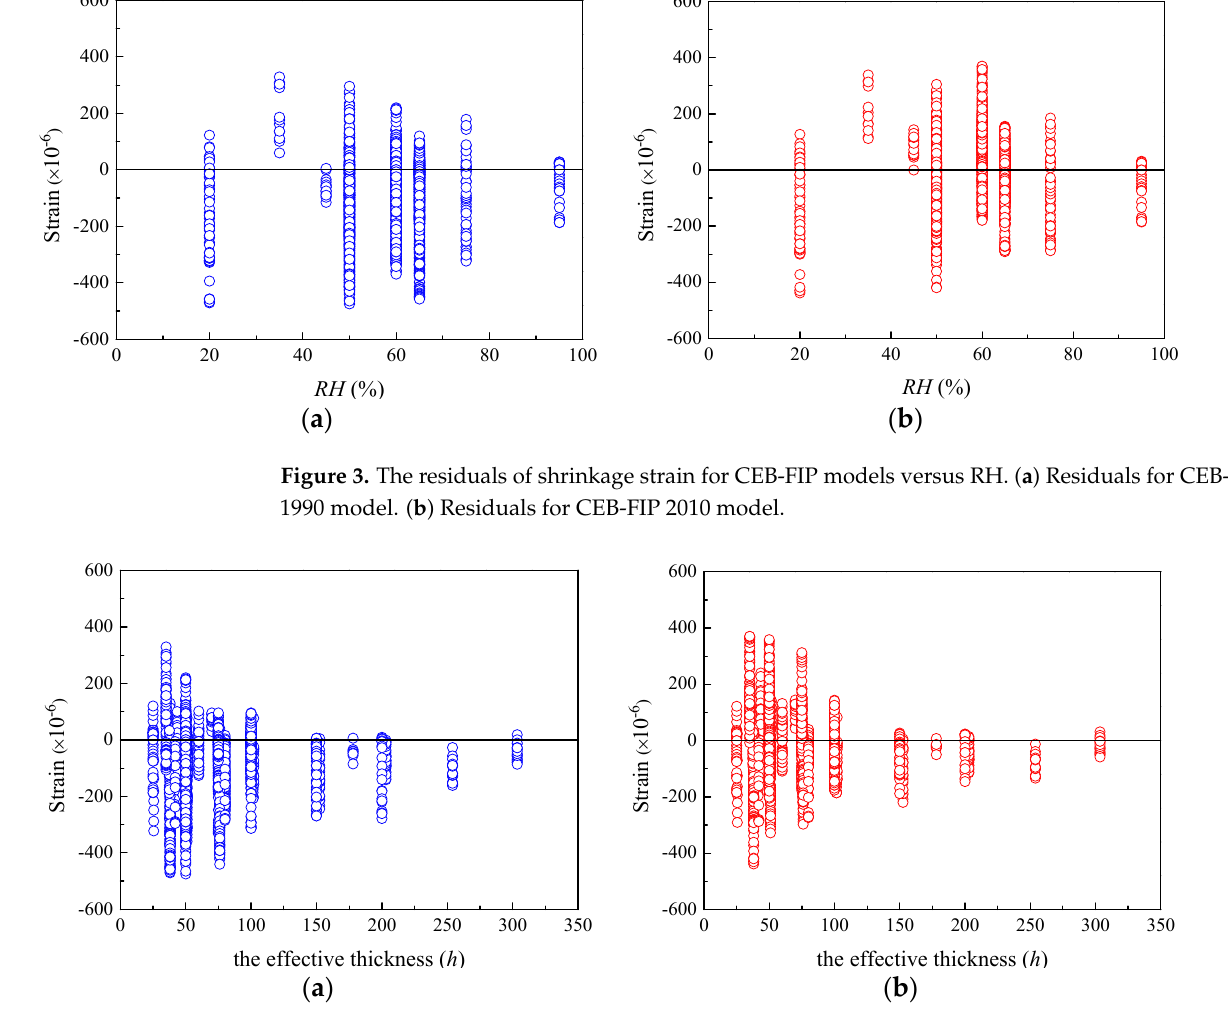
Figure 4. The residuals of shrinkage strain for CEB-FIP models versus h. ( a ) Residuals for CEB-FIP 1990 model. ( b ) Residuals for CEB-FIP 2010 model.